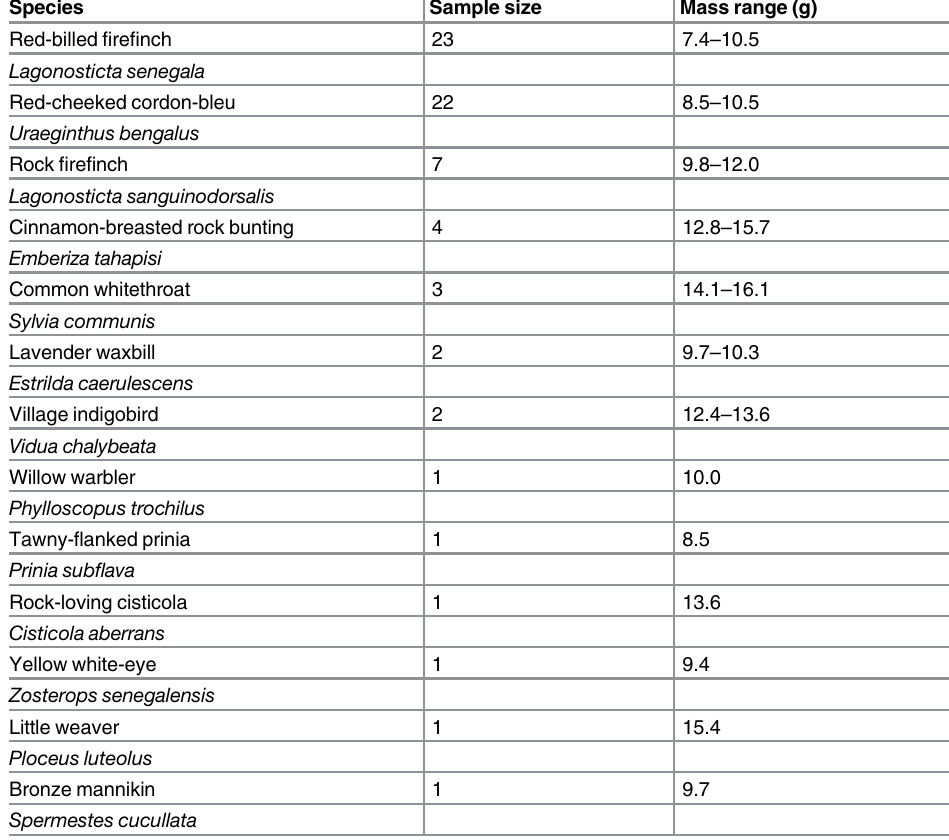
Table 1. Species included in the analyses and their sample size and measured mass range. Nomen- clature following Barrow and Demey [19]. Species Sample size Mass range